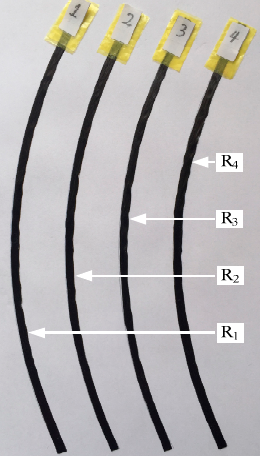
Figure 12. The 2 layers of test pieces.